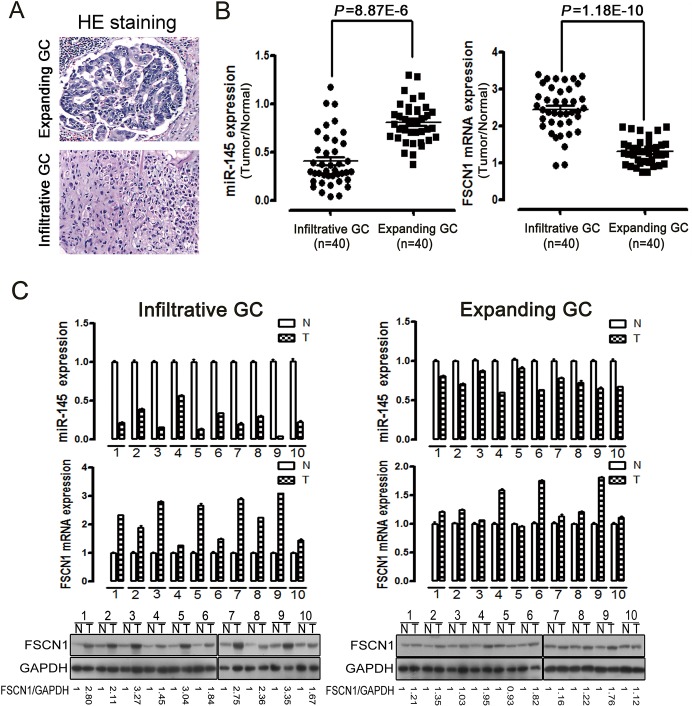
Strong inverse relation between miR-145 expression and FSCN1 expression in human infiltrative type gastric cancer.(A) Gastric cancer samples derived from 80 patients were classified as indicated by the representative HE staining. (B) qPCR data of miR-145 levels in infiltrative gastric cancer (n = 40) compared to expanding gastric cancer (n = 40) (P = 8.87E-6) (left), and qPCR data of FSCN1 mRNA levels in infiltrative gastric cancer (n = 40) compared to expanding gastric cancer (n = 40) (P = 1.18E-10) (right). (C) Representative expression of miR-145 and FSCN1 mRNA/protein levels in 10 infiltrative gastric cancer samples and 10 expanding gastric cancer samples along with their adjacent normal tissues (N, adjacent normal tissue; T, tumor tissue). Arabic numbers indicate individual sample pairs. The data are presented as the mean±SD of three independent experiments.